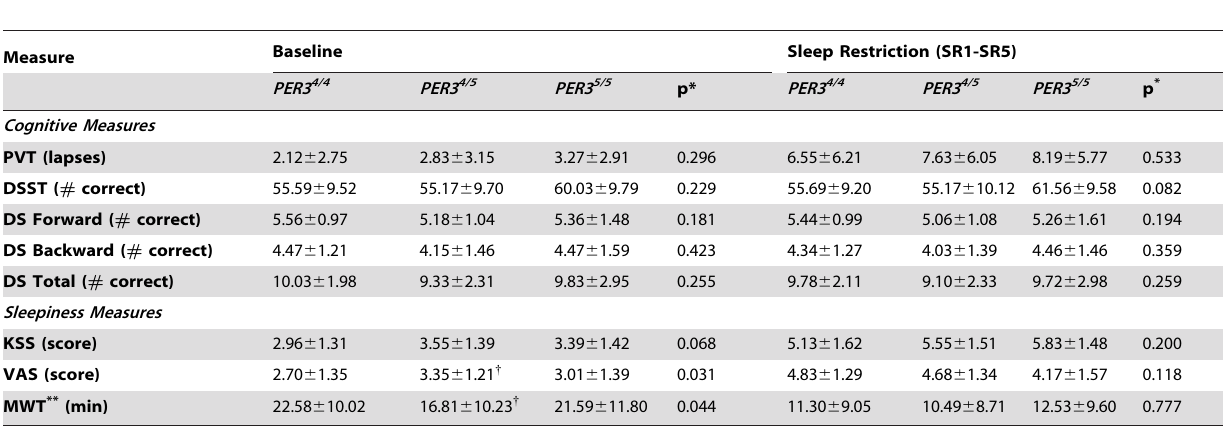
Table 2. Cognitive and Sleepiness Measures at Baseline and Across Sleep Restriction in PER3 4/4 , PER3 4/5 and PER3 5/5 Subjects (Mean 6